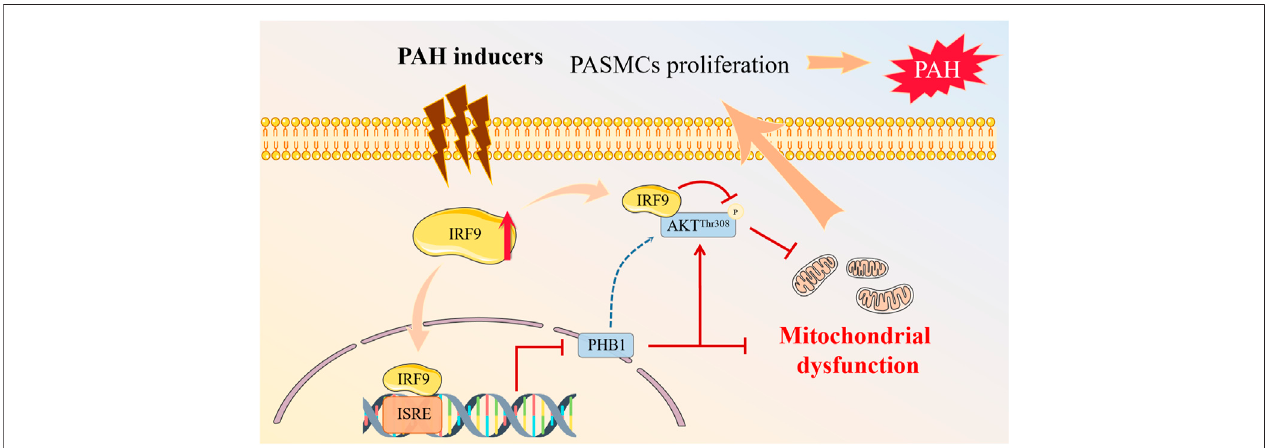
FIGURE 7 | Proposed mechanisms of IRF9 regulates proliferation of PASMCs in PAH. Multiple PAH inducers promote the expression of IRF9. On the one hand, increased IRF9 directly interacts with AKT to regulate the phosphorylation of AKT at T308 site, and on the other hand, IRF9 acts as a transcription factor to inhibit the expression of PHB1, which together leads to mitochondrial dysfunction in PASMCs, which in turn promotes PASMCs proliferation, and ultimately contributes to PAH